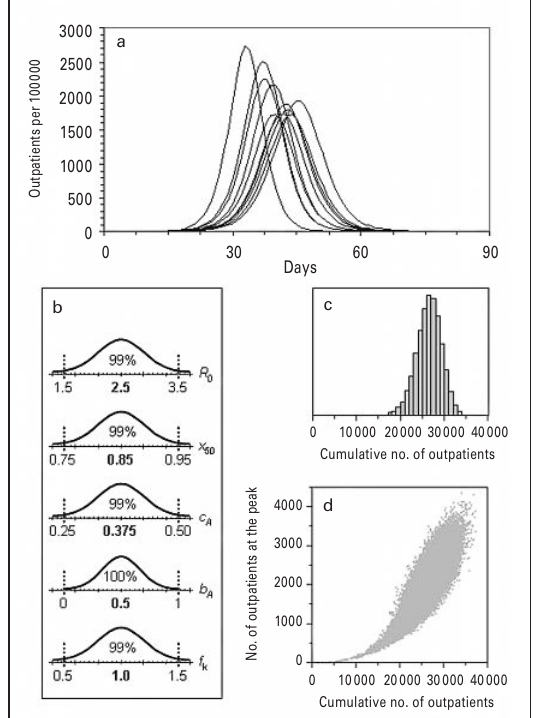
Variability in the number of outpatients and their distribution originating from variabil- ity in the parameters under the no-intervention scenario (population size 100000 individuals). (a) Epidemic curves for nine out of 100000 realizations, representing the 10%, 20%, ..., 90% percentiles of all realizations, whereby ranking is based on the cu- mulative number of outpatients. (b) Parameter values for each realization are sampled independently from normal distributions (means given in bold, 99% of the values lie within the ranges specified by dotted lines, except b A which is truncated). R 0 : basic reproduction number, x 50 : cumulative infectivity during the first half of the sympto- matic period, c A : fraction of infections remaining asymptomatic, b A : relative infectivity of asymptomatic compared to symptomatic cases, f k : factor by which the InfluSim default percentage of hospitalizations was varied (see table A1 in the Appendix). (c) Distribution of the cumulative number of outpatients. (d) Correlation between the cumulative number of outpatients and the number of outpatients at the peak day. Both values approach zero for very low values of R 0